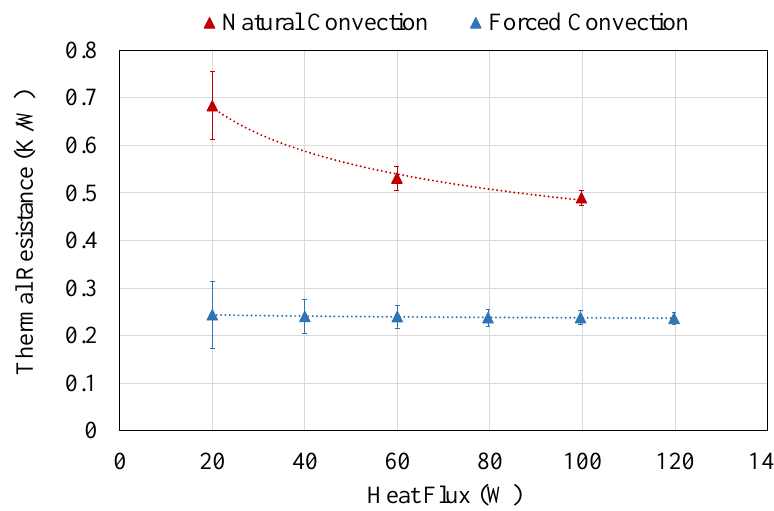
Figure 3. Thermal resistance of the cold side heat exchanger for different heat fluxes, considering natural and forced convection.